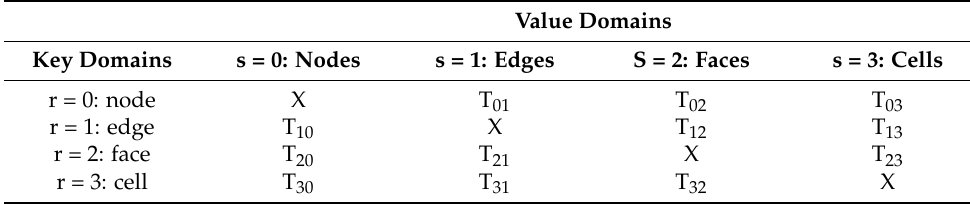
Table 5. Matrix of the Topological Tables T rs